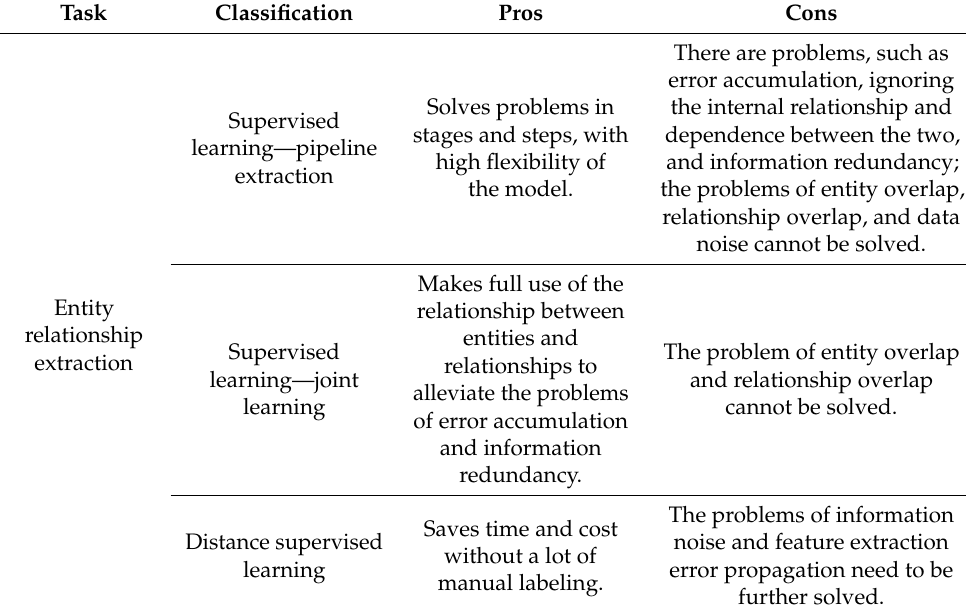
Table 4. The characteristics of DL models in different IE